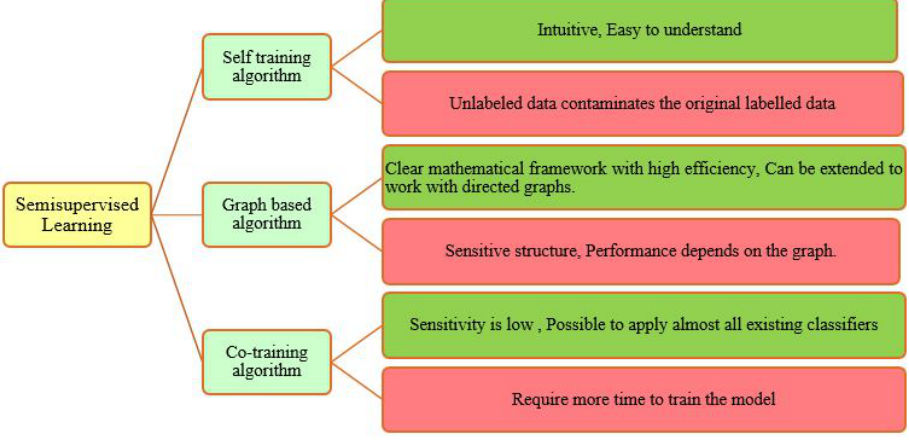
Figure 13. Pros. (Light Green) and Convs. (Light Red) of Semi-supervised learning models